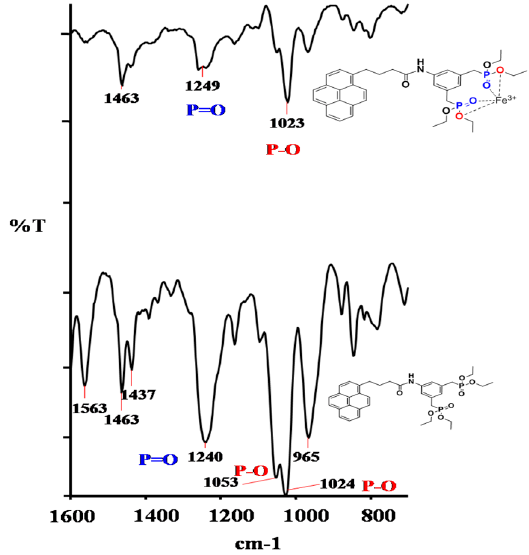
Figure 6. Comparison between the FT-IR spectral data of receptor 1 and the 1 –Fe 3+ ion complex.